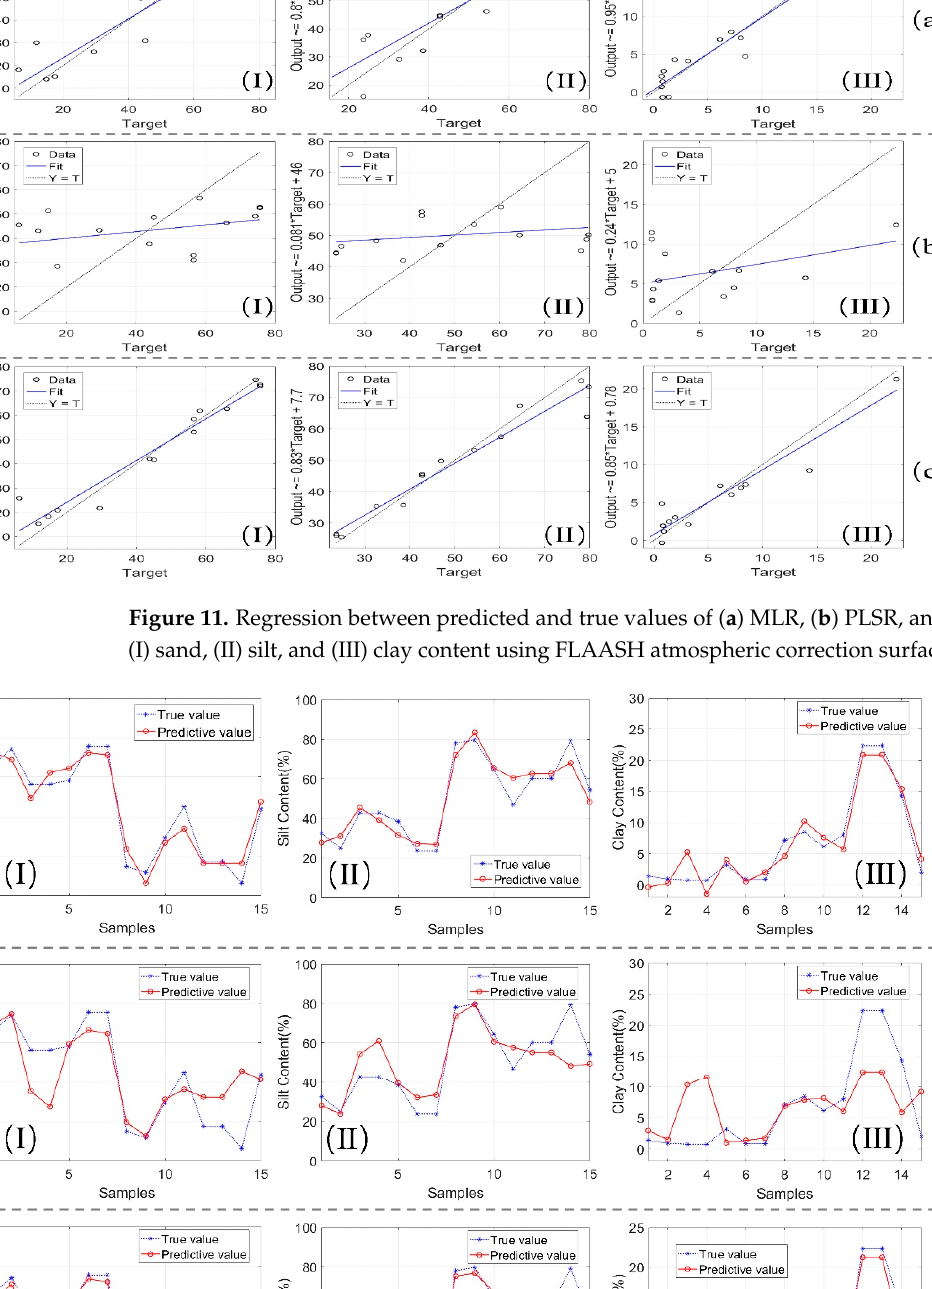
Figure 10. Fitting effect of ( a ) MLR, ( b ) PLSR, and ( c ) SVM models, (I) sand, (II) silt, and (III) clay content predicted, and true values using FLAASH atmospheric correction surface reflectance data.